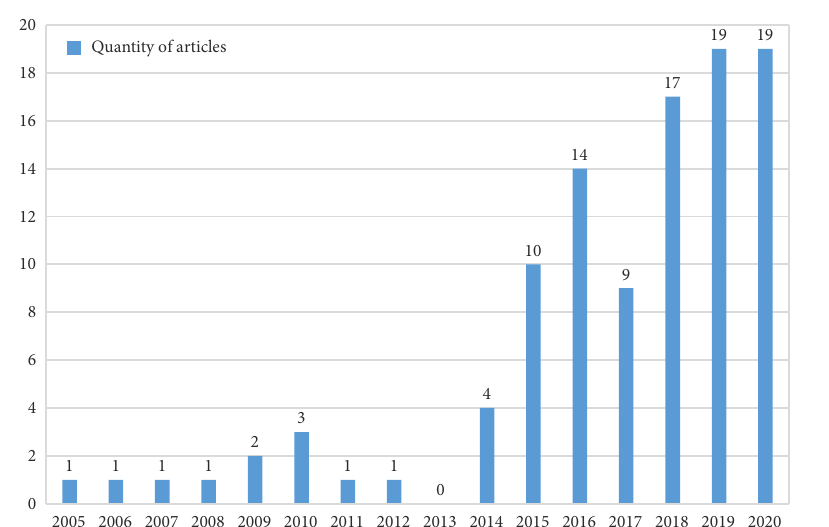
Figure 2. Distribution of published articles per year (2005–September